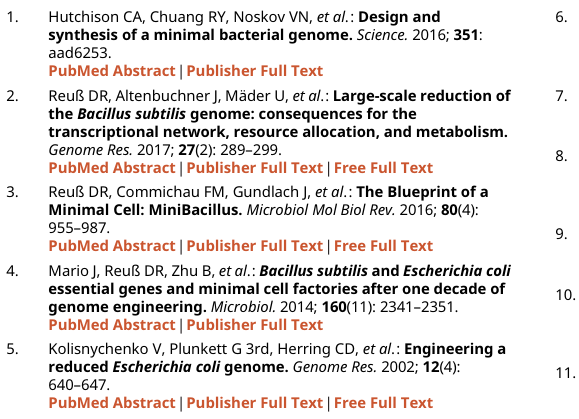
Figshare:Extendeddatafor ‘ Apan-genome methodtodeterminecoreregionsofthe Bacillussubtilis and Escherichiacoli genomes ’ , https://doi.org/10.6084/m9.figshare.15129636.v1. 58